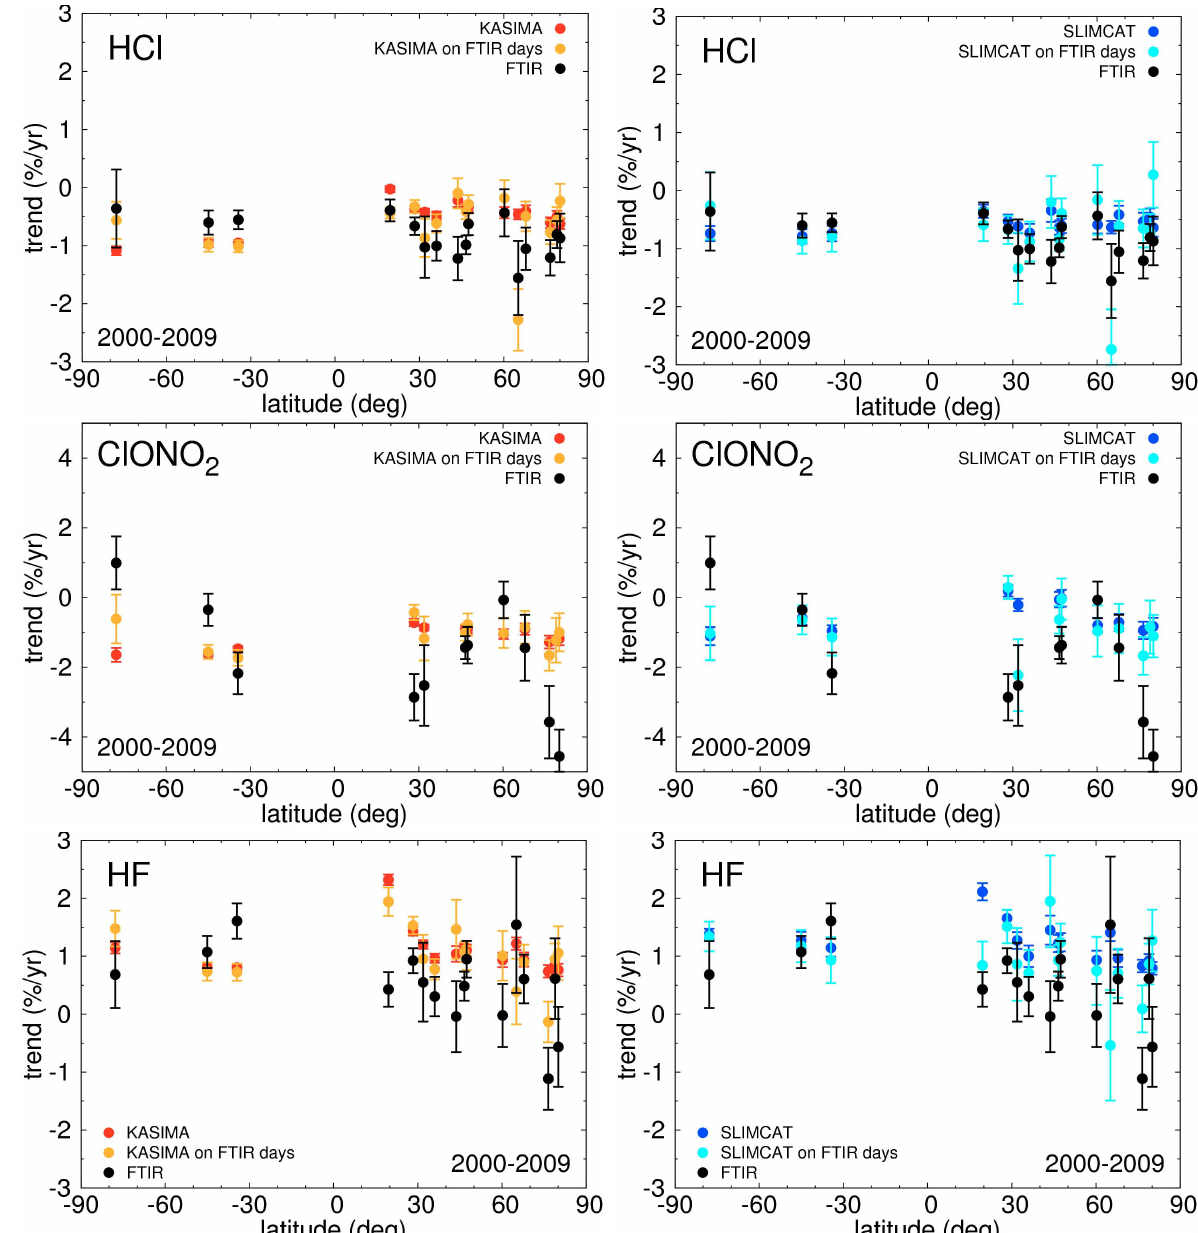
Fig. 11. The dependence of the resulting trend (in % per year) on sampling is investigated by comparing trends from the KASIMA data on all days (left column; red) with those calculated from the model time series on days with FTIR measurements only (orange) and with the FTIR trends themselves (black). The same comparison is shown for SLIMCAT (right column; blue) and SLIMCAT only on FTIR days (cyan). Please note the different y-scales. The error bars were determined with the bootstrap